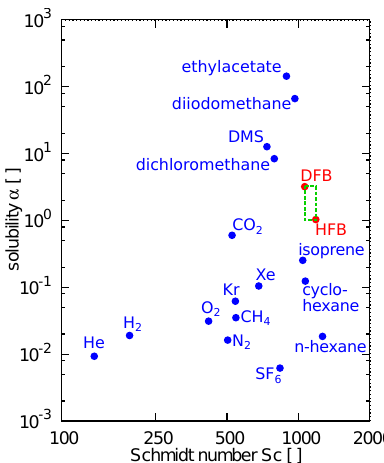
Fig. 8. Double logarithmic Schmidt number–solubility diagram of some environmentally important tracers for a temperature of 25 ◦ C. The tracers used in this study, hexafluorobenzene (HFB) and 1,4-difluorobenzene (DFB), cover a very limited parameter range, marked by the dashed green